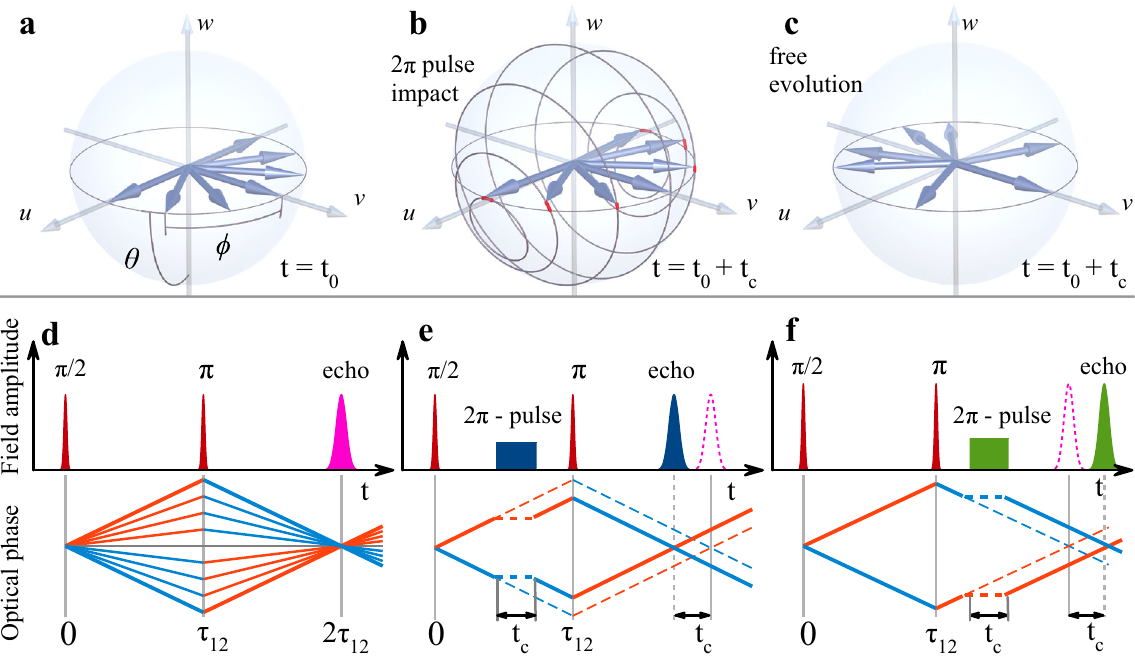
Fig. 1 Photon echo (PE) timing. Schematic illustration of coherent evolution of an exciton ensemble on the Bloch sphere. a Partial dephasing of excitons with different detunings at time t 0 after excitation with a π /2-pulse. b Nutation of excitons by the action of control pulse with a pulse area of 2 π (solid gray lines) and weak deviations from pure 2 π rotations due to detunings at time t 0 + t C with t C ≈ Δ − 1 , where Δ corresponds to maximum detuning of the inhomogeneous ensemble (red lines). For detuned excitons, the rotation occurs with the generalized Rabi frequency which is larger and consequently leads to a deviation from 2 π rotation. c Distribution of Bloch vectors at the same time as in b ; however, without impact of the control pulse. d Phase evolution of excitons in a two-pulse PE sequence from the excitation pulse at t = 0 to the photon echo at t = 2 τ 12 . Positive ( Δ > 0) and negative ( Δ < 0) detunings of the exciton resonances are shown by red and blue lines, respectively. First and second excitation pulses are shown in red and magenta peak corresponds to the primary two-pulse PE. e , f Two-pulse PE in presence of the additional 2 π pre-pulse (blue) or post-pulse (green) leading to an advanced and retarded PE peak. The evolution of optical phase in presence of the control pulse is shown by solid lines, whereas dashed lines indicate the evolution without the control